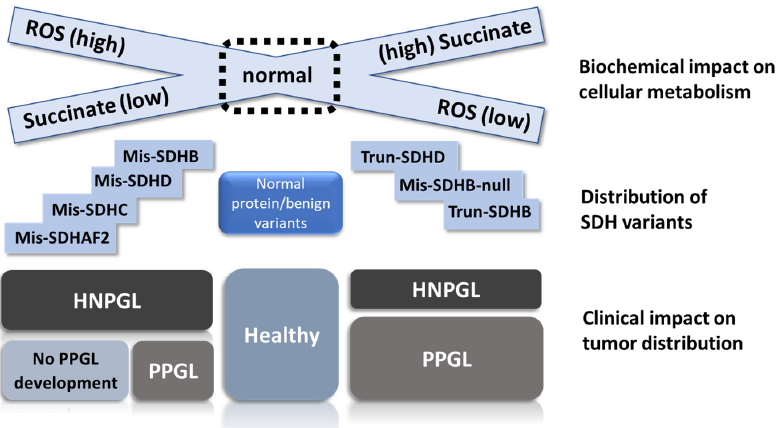
Figure 4. Visual depiction of the relation between SDH biochemistry, SDHx variant type and disease outcome. We propose that ROS accumulation occurs primarily due to the missense variants on the right of the illustration. In this scenario, SDHB missense variants fall primarily into one of two dif- ferent sets, either as high-ROS hypomorphic alleles similar to SDHC/D missense variants or as low- ROS null alleles functionally equivalent to truncating variants. Truncating variants prevent SDH assembly, leading to the loss of succinate oxidation and accumulation of high levels of the substrate, together with elevated ROS levels that are generally lower compared to missense variants. High levels of succinate limit the generation of ROS at SDHA FAD. HNPGL precursor cells appear rela- tively agnostic regarding missense or truncating variants, whereas PPGL precursor cells show a substantial bias against SDHAF2, SDHC and SDHD missense variants, likely due to ROS overload and subsequent cell death, resulting in substantially less tumor development compared to better- protected HNPGL precursor tissues. Mis = missense, Trun = truncating, ‘null’ indicates missense variants that act as null alleles. variants that act as null